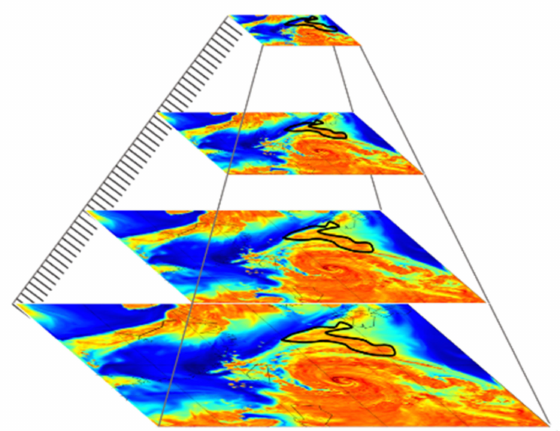
Figure 4. Schematic diagram of image pyramid method with an original size at the bottom and the resizing rate of